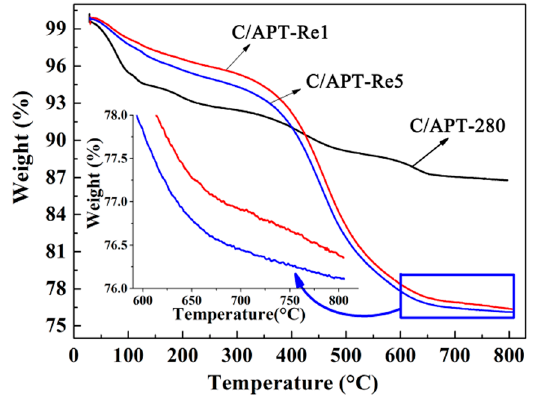
Figure 5. TG curves of C/APT-280, C/APT-Re1, and C/APT-Re5.